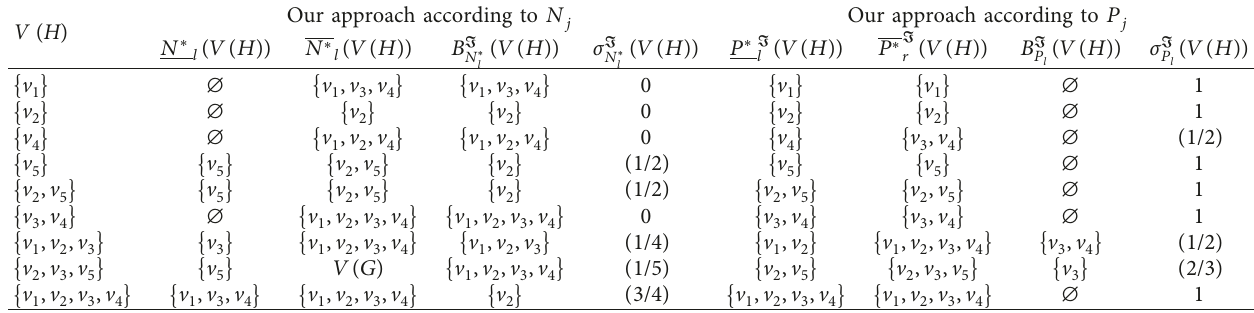
Table 4: Comparisons between the lower approximations, upper approximations, j -boundary, and j -accuracy measures by using our approaches for j � l .